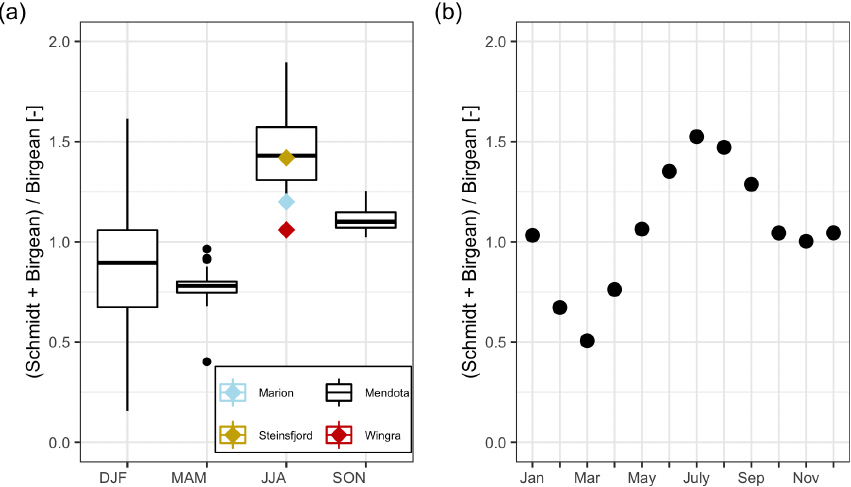
Figure 7. Dynamics of the average HBR = (St + B)/B over time. (a) Boxplots of the HBR over the meteorological seasons, which represent seasonal quarters of the year beginning in December. The summer HBR values for Lake Marion, Lake Steinsfjord, and Lake Wingra were taken from Kjensmo (1994). (b) Scatterplot of the average HBR values for each